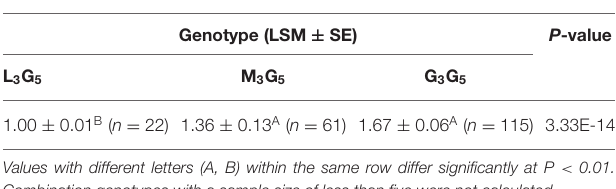
TABLE 6 | Least squares mean and standard error for litter size of different combination genotypes of CNV3 and CNV5 within the Fec B gene in Shaanbei white cashmere goats.